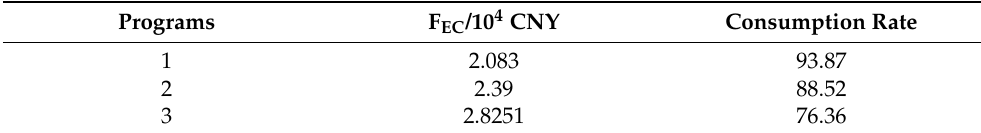
Table 6. Operating cost and consumption rate.